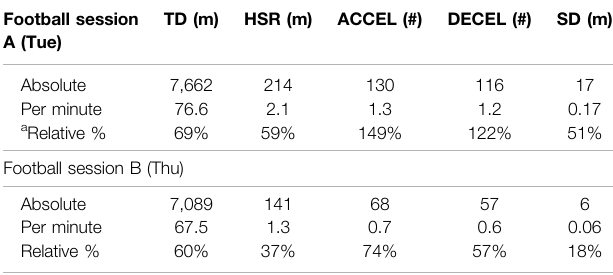
TABLE 1 | Football training sessions one and